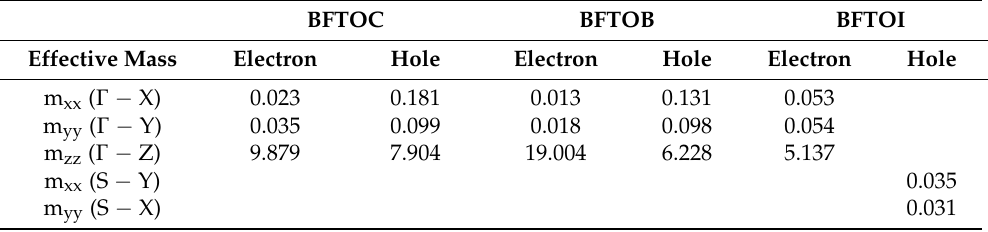
Figure 1. ( a ) Crystal structure of BFTOX. Band structures of ( b ) BFTOC, ( c ) BFTOB and ( d ) BFTOI. Table 1. Calculated effective masses (unit m 0 ) of the electrons and holes of BFTOC, BFTOB and BFTOI by different directions.